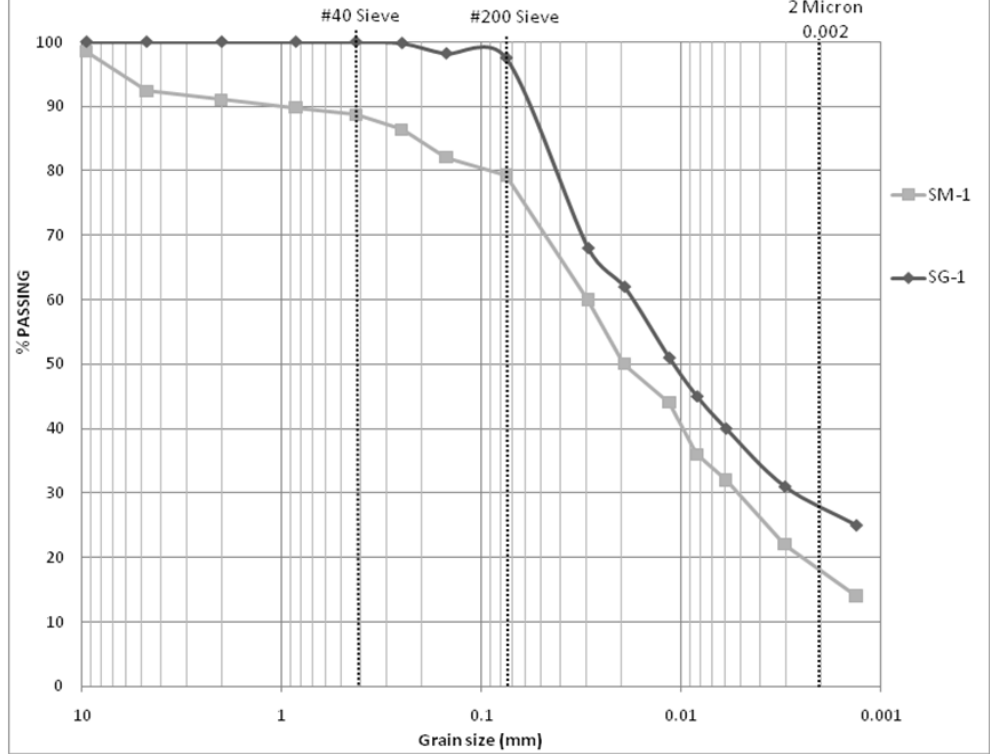
Figure 5. Comparison of grain size distributions: manually processed stockpiled sample (SM-1) vs . grinder processed stockpiled sample (SG-1).